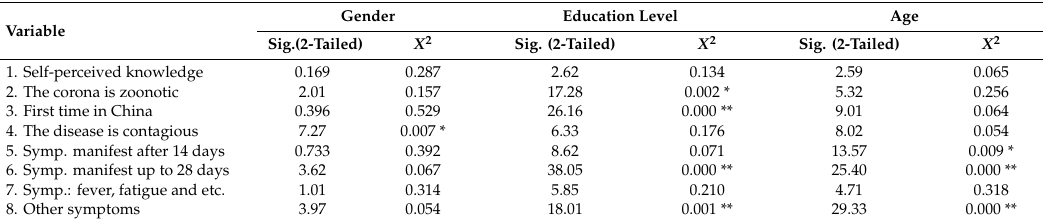
Table 3. Chi-square test results between gender, education level, age variables and knowledge of